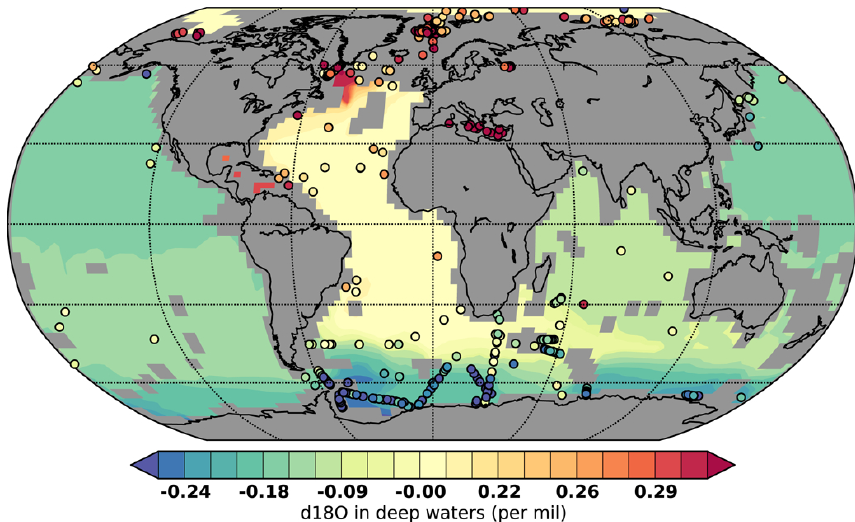
Fig. 12. Mean 2500–3500m depth δ 18 O in sea water in i LOVECLIM compared to the GISS database (Schmidt et al., 1999) (coloured circles).